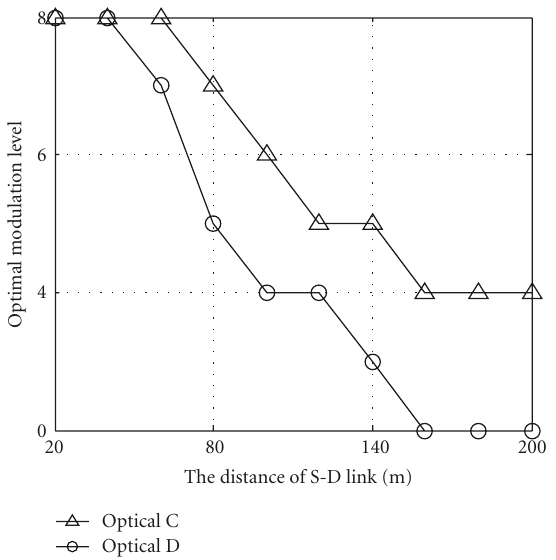
Figure 7: Optimal modulation level versus the S-D distance for cooperation and direct transmission